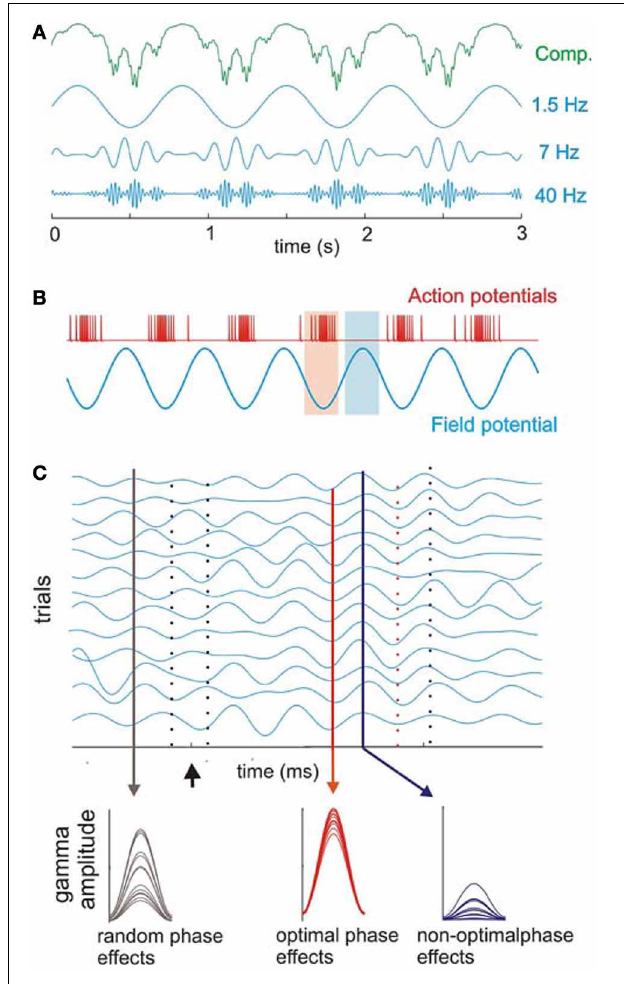
FIGURE 6 | Cross-frequency coupling between delta, theta, and gamma bands. (A) Recorded oscillations (top, green) reflect complex (Comp.) combinations of components at different frequencies. Blue traces illustrate component delta (1.5Hz), theta (7Hz), and gamma (40Hz) band oscillations that together make up the complex, combined signal (green illustration) recorded prior to filtering the signal into component frequency bands. Coupling between frequencies is hierarchical in organization such that gamma oscillatory amplitude varies with the phase of underlying theta oscillation, and theta in turn varies with the phase of underlying delta oscillation. (B) Action potential firing rate and local field potentials illustrate high and low excitability phases of ongoing neuronal oscillations. (C) Simulated single-trial responses demonstrate the effects of visual inputs on A1 activity. Oscillations within a given frequency are highly phase-variable across trials (black drop line on left) until a modulatory event (i.e., one that alters activity to a sub-threshold degree but does not reach significant enhancement or depression of the response; arrow) occurs. This event can cause a phase-reset of ongoing oscillations and can produce strong phase coherence. During such coherence, peaks, and troughs of ongoing oscillations align across trials (red solid and dotted lines, respectively) with both optimal and non-optimal phases that occur in temporally predictable patterns (red and blue lines illustrating low vs. high phase variability across trials, respectively). Sensory inputs (in this case, visual inputs to A1) can be timed such that they arrive either: (1) in random phase with the ongoing oscillation (black drop line in C ) and generate highly variable response amplitudes (bottom; observed as random phase effects); (2) during (Continued)